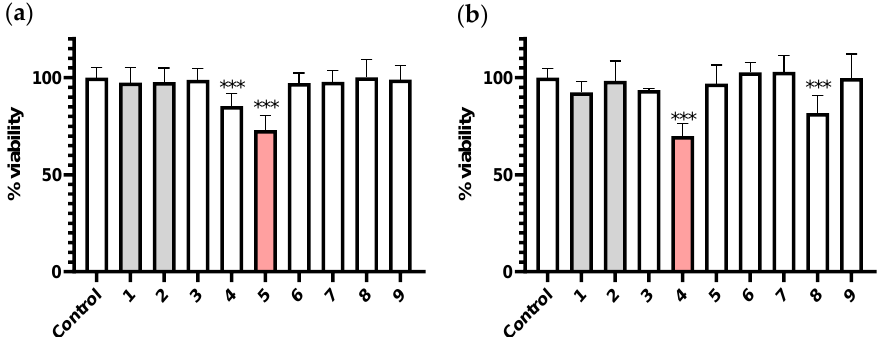
Figure 2. Effect of eugenol and its derivatives (100 µ M) in ( a ) AGS and ( b ) A549 cell lines. The results correspond to the mean of each well of three independent experiments performed in triplicate. *** p < 0.001.